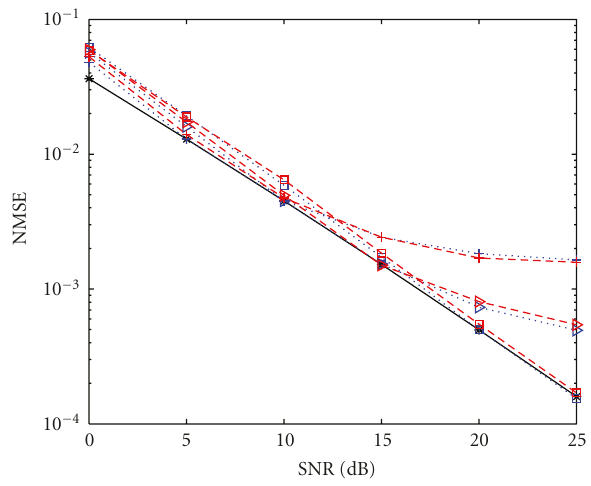
Figure 7: NMSE of the proposed fast LMMSE algorithm with matched SNR and mismatched SNRs versus SNR, by simulation and numerical method,